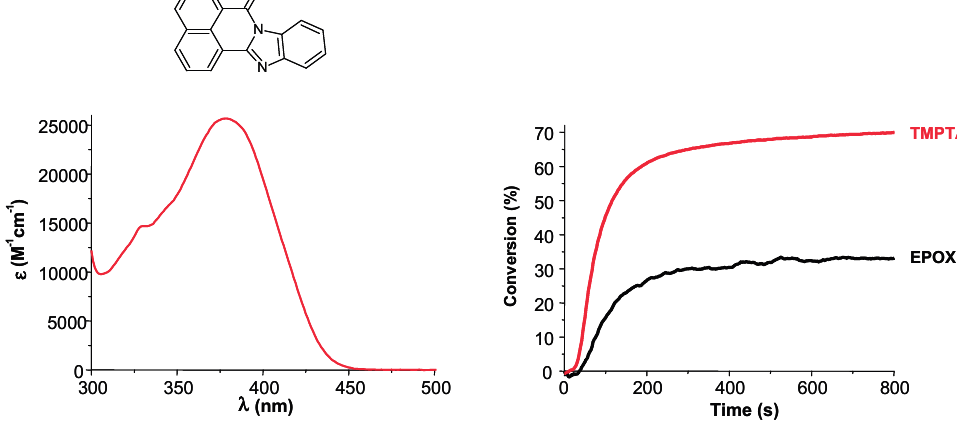
Figure 8. Interpenetrating polymer network production. Design of high performance photoinitiator (NA3) at 385–405 nm based on the naphthalene scaffold [118]: ( left ) absorption spectrum of NA3 and ( right ) Photopolymerization profiles of an EPOX/TMPTA blend (50%/50%, w / w ) in the presence of NA3/Iod/NVK (0.5%/2%/3%, w / w / w ) in laminate upon the halogen lamp exposure.